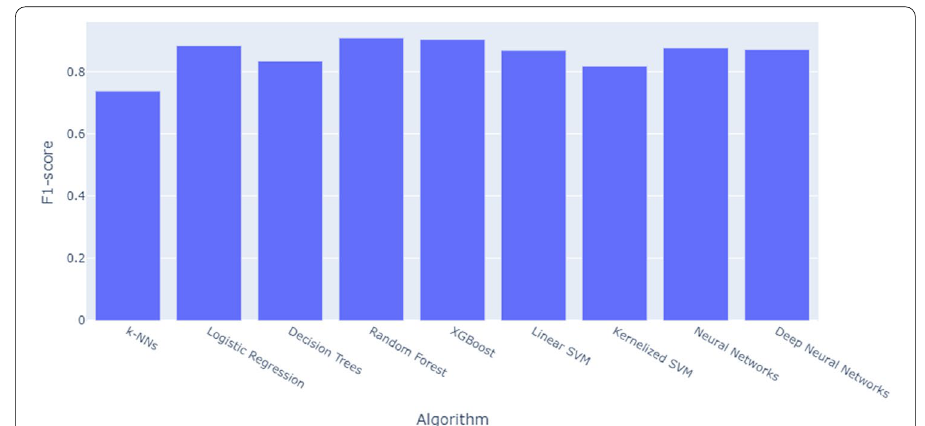
Fig. 2 Comparison of f1‑scores for the nine classification algorithms